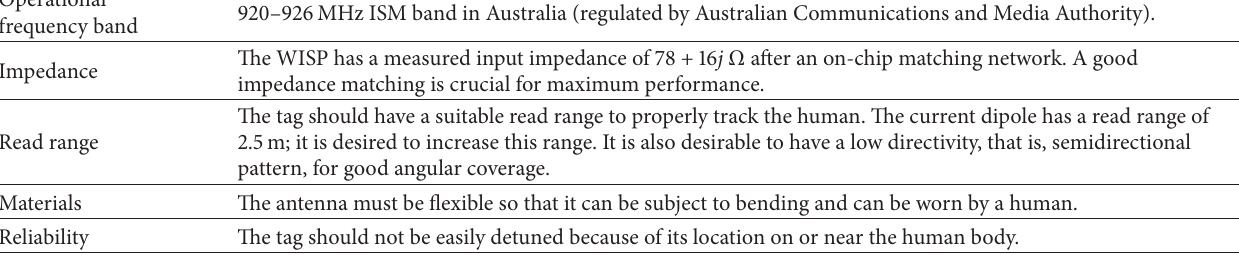
Table 1: Antenna requirements and